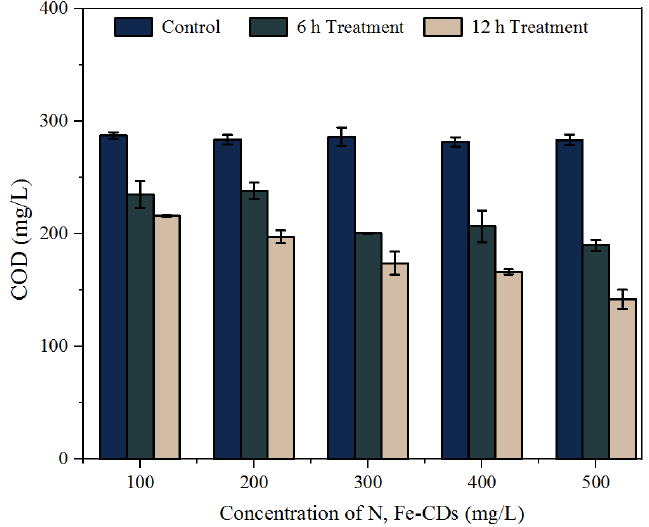
Figure 7. Effects of treatment with N,Fe-CDs on COD of KWE.